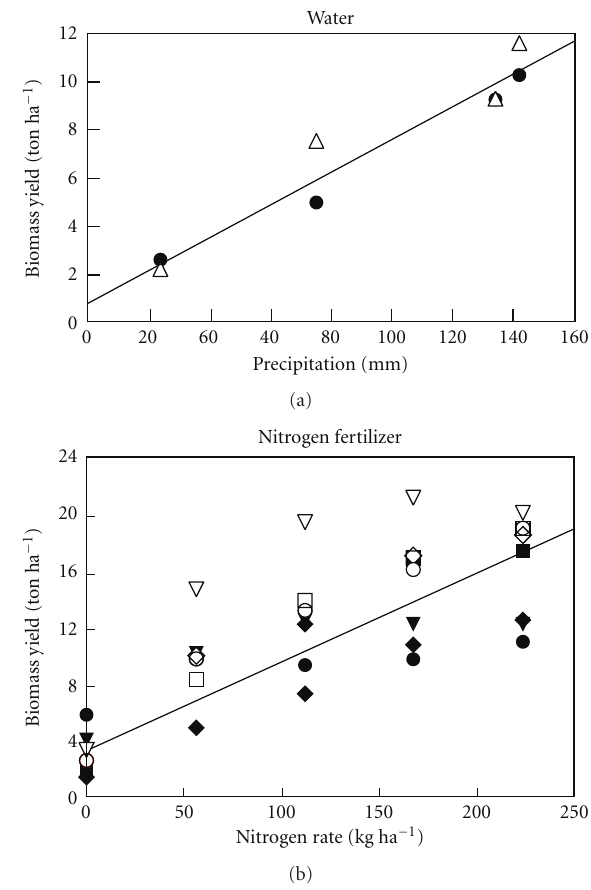
Figure 1: Biomass productivity depends on water and nutrients